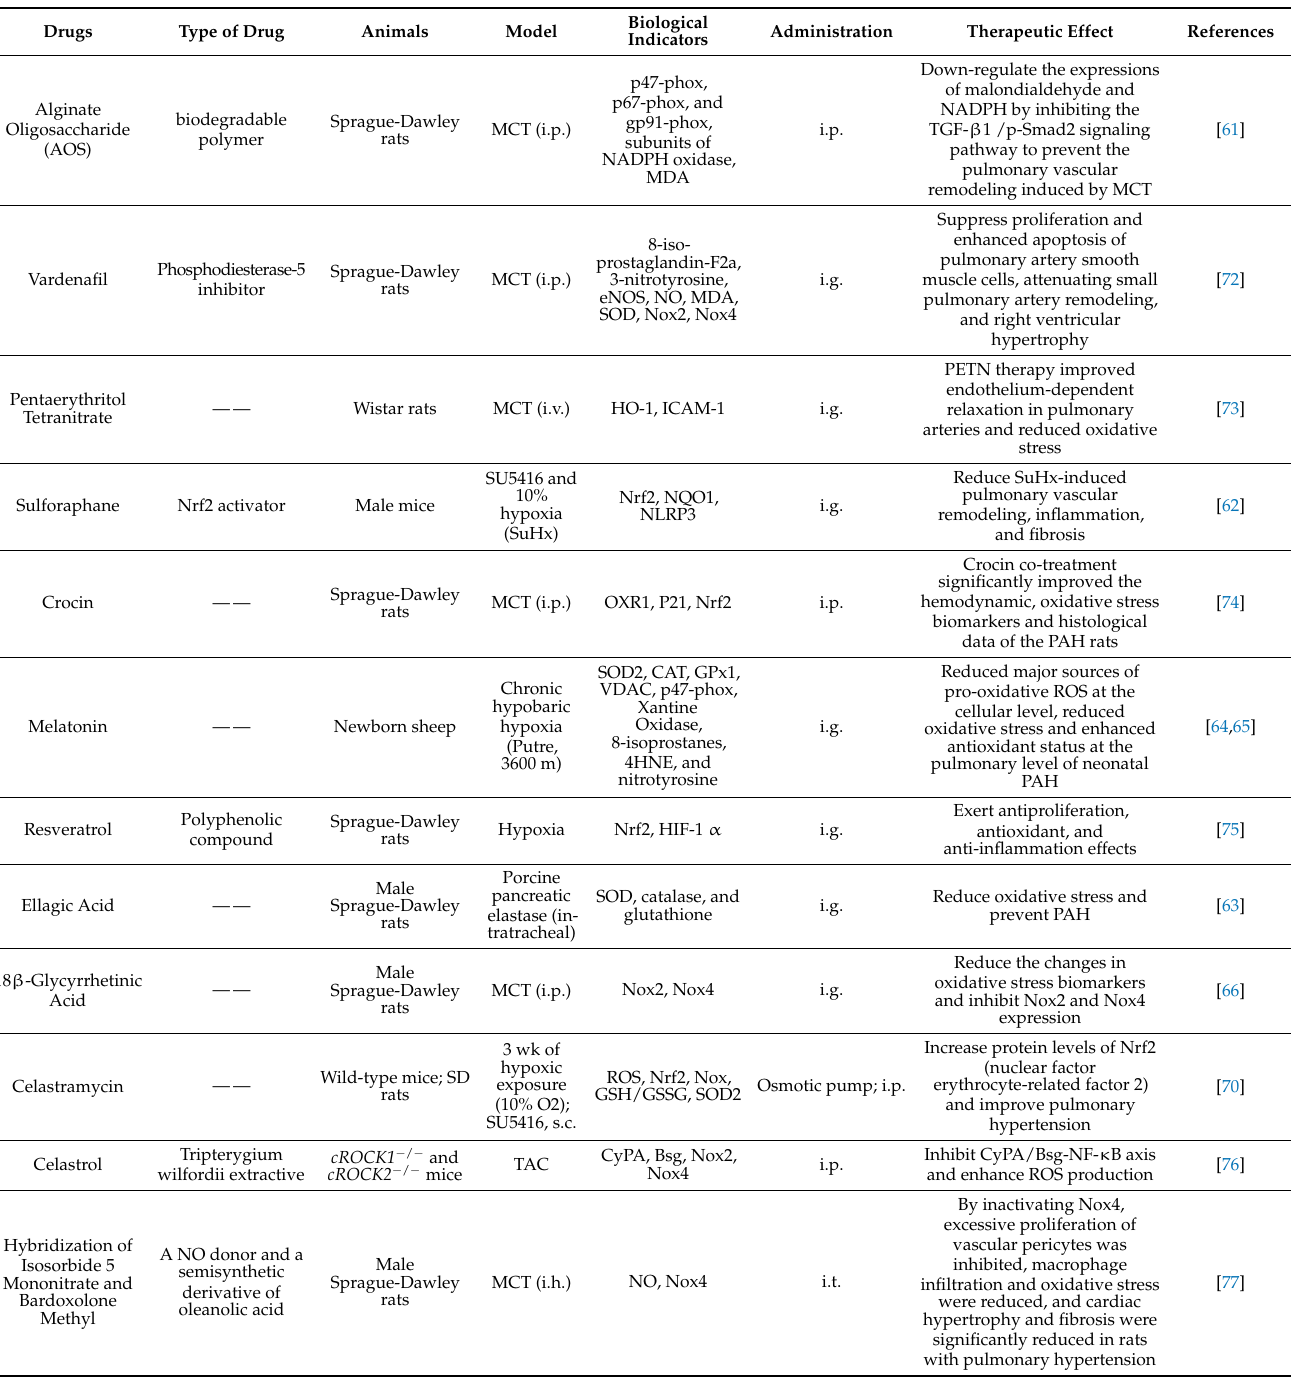
Table 1. Preclinical treatments and mechanisms targeting oxidative stress in